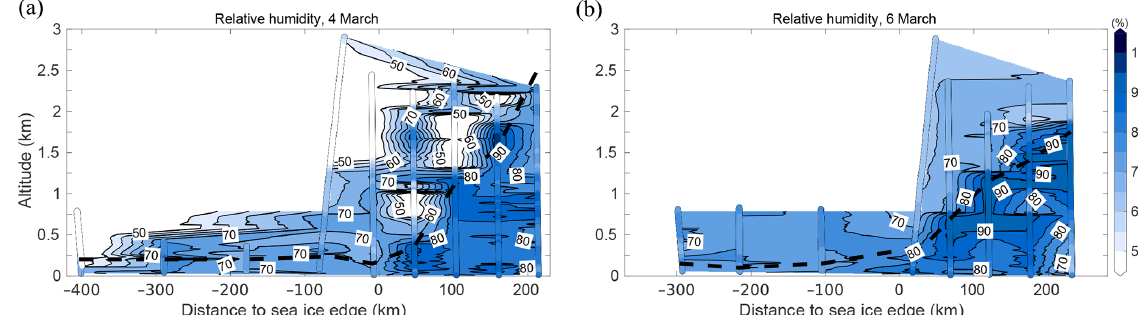
Figure B1. Same as Fig. 6, but vertical cross sections are shown for the total values of relative humidity on (a) 4 March and (b) 6 March 2013. Modified based on Tetzlaff et al. (2014) and Tetzlaff (2016).